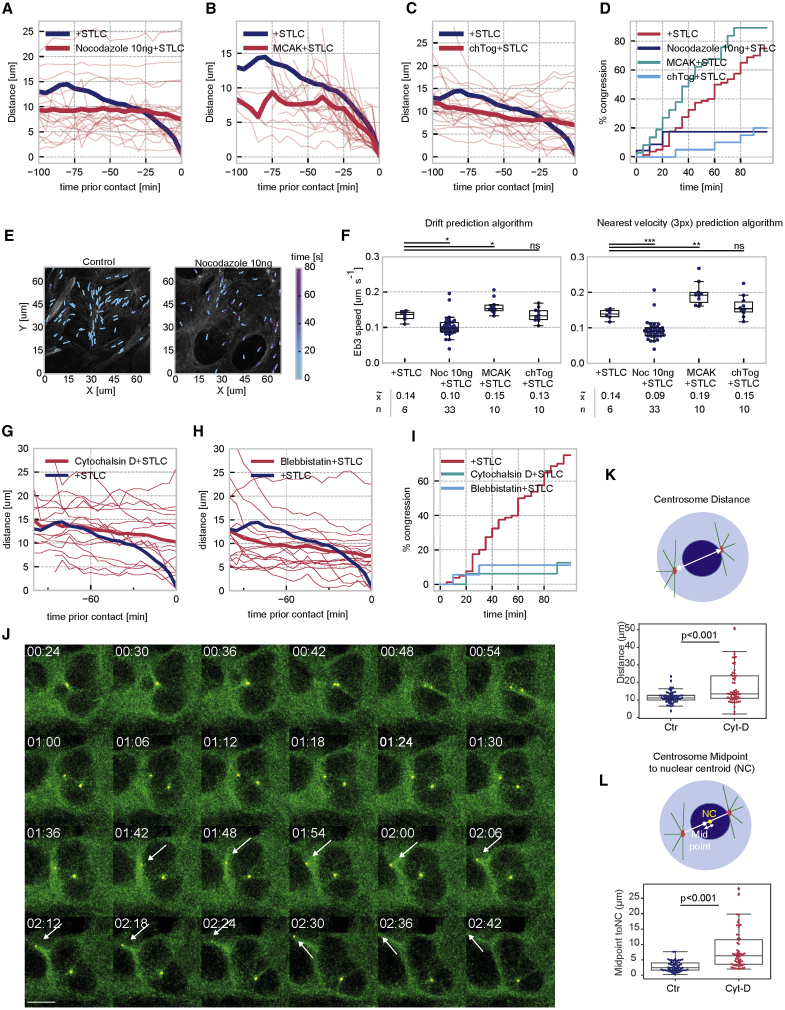
Centrosome Congression Depends on MT Polymerization(A–C) Measuring congression after manipulating MT polymerization Following 20-h arrest in 2 μM 1NM-PP1, cells with two separated centrosomes were followed by live-cell imaging after treatment with 5 μM STLC, and centrosome position was tracked to measure inter-centrosomal distance over time. (A) Cells treated with 10 ng/mL nocodazole. (B) Cells following 48-h MCAK siRNA depletion. (C) Cells following 48-h ch-TOG siRNA depletion. For all graphs, the bold blue line indicates the average congression tracks of control cells (see Figure 1). Individual tracks of cells are shown in red, and bold red lines represent the mean values.(D) Quantification centrosome congression. Data from (A)–(C) were used to calculate percentage of cells in which centrosomes joined together over time following the different treatments indicated in the legend. Each treatment was repeated in at least three independent experiments with total n = 23 (Noc), n = 20 ch-TOG), and n = 37 (MCAK).(E) EB3 comet tracking. Examples of MT tracking in RFP-EB3-expressing U2OS cdk1as cells following 20-h treatment with 1 μM 1NM-PP1.(F) Quantification of MT tracking. EB3 tracks in cells subjected to indicated treatments were analyzed using drift prediction and nearest speed tracking algorithms with a search radius of 3 pixels. Data were plotted for each condition as swarm/boxplots showing the mean of individual tracks per cell and the median plus 25 and 75 percentiles. p values were estimated using a two-sided t test.(G–I) Centrosome congression following changes in actin dynamics. As in Figure 2, U2OS cdk1as cells were treated for 20 h with 2μM 1NM-PP1, and cells with two separated centrosomes were analyzed by live-cell imaging and centrosome tracking following STLC treatment to measure inter-centrosomal distance over time. Cells were pretreated for 1 h with (G) 2 μg/mL cytochalasin D and (H) 5 μM blebbistatin. For all graphs, the bold blue line indicates the average congression tracks of control cells (see Figure 1). Individual tracks of cells are shown in red, and bold red lines represent the mean values. (I) Quantification centrosome congression. Data from (A)–(C) were used to calculate percentage of cells in which centrosomes joined together over time following the different treatments indicated in the legend. Each treatment was repeated in at least three independent experiments with total n = 18 (Blebbistatin), n = 16 (Cytochalasin-D).(J) Centrosome separation in cytochalasin-D-treated cells (see also Video S4). Images of time-lapse video showing centrosome separation (green, GFP-alpha-tubulin; red, RFP-PACT; time is indicated in h:min on the top left, and scale bar represents 10 μm) following STLC washout in cells that were treated with 2 μM 1NM-PP1 and 5 μM STLC for 20 h. Following an hour-long pretreatment with cytochalasin D, cells were washed with STLC-free medium before imaging.(K) Quantification of centrosome distance. Maximal distance was measured 2 h after STLC release.(L) Quantification of centrosome alignment. Geometrical alignment of centrosomes toward the nuclear centroid was measured as the distance from the midpoint between centrosomes to the nuclear centroid position (see diagram for graphic representation).Data in (F) and (G) are from three experiments (total n > 50 for each condition).For (F), (K), and (L), p values were calculated using an independent two-sample t test. Levels of significance are indicated by stars (∗p < 0.05, ∗∗p < 0.01, ∗∗∗p < 0.001). The boxplot indicates median, first and third quartiles, and minimum/maximum values.